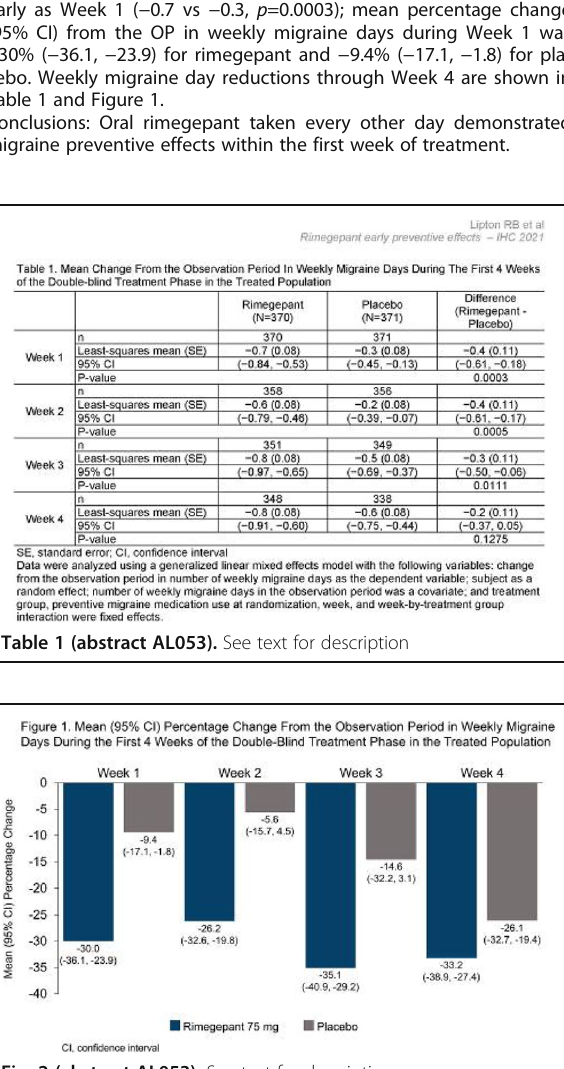
Fig. 2 (abstract AL053). See text for description